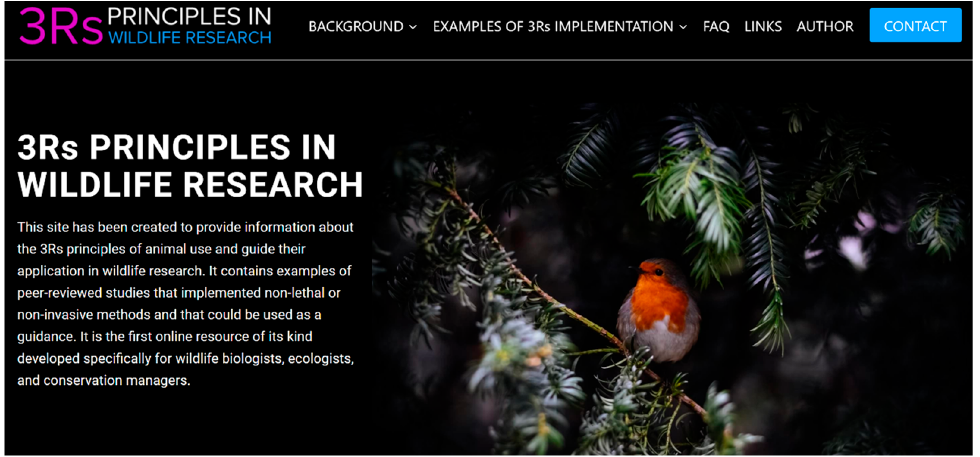
Figure 2. Homepage of the informational website and database 3Rs Principles in Wildlife Research (https://3RsWildlife.info, accessed on 15 May 2021).